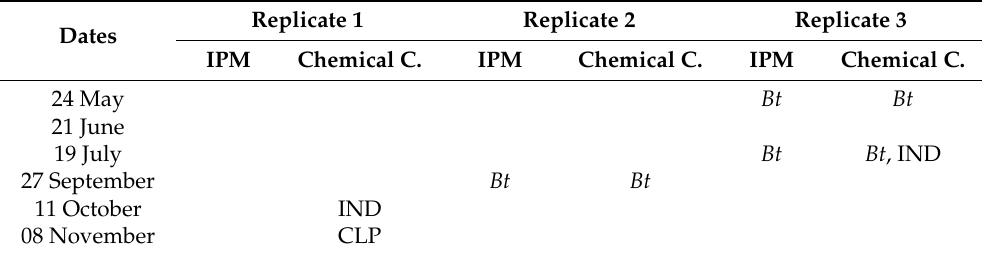
Table 4. Insecticide applications in each plot in